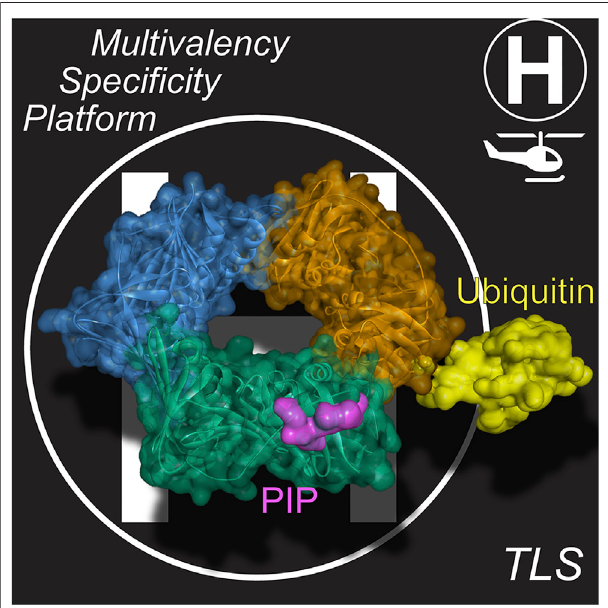
FIGURE 2 | PCNA is a dynamic “ landing-pad ” (or platform). PIP binding sites at the interdomain connecting loop (IDL) and ubiquitination at K164 are available on each of the three PCNA subunits, providing for multivalency. Structural model derived from PCNA/p21 peptide structure (PDBID: 1AXC) (Gulbis et al., 1996) and monoubiquitinated PCNA structure (PDBID: 3TBL) (Zhang et al.,